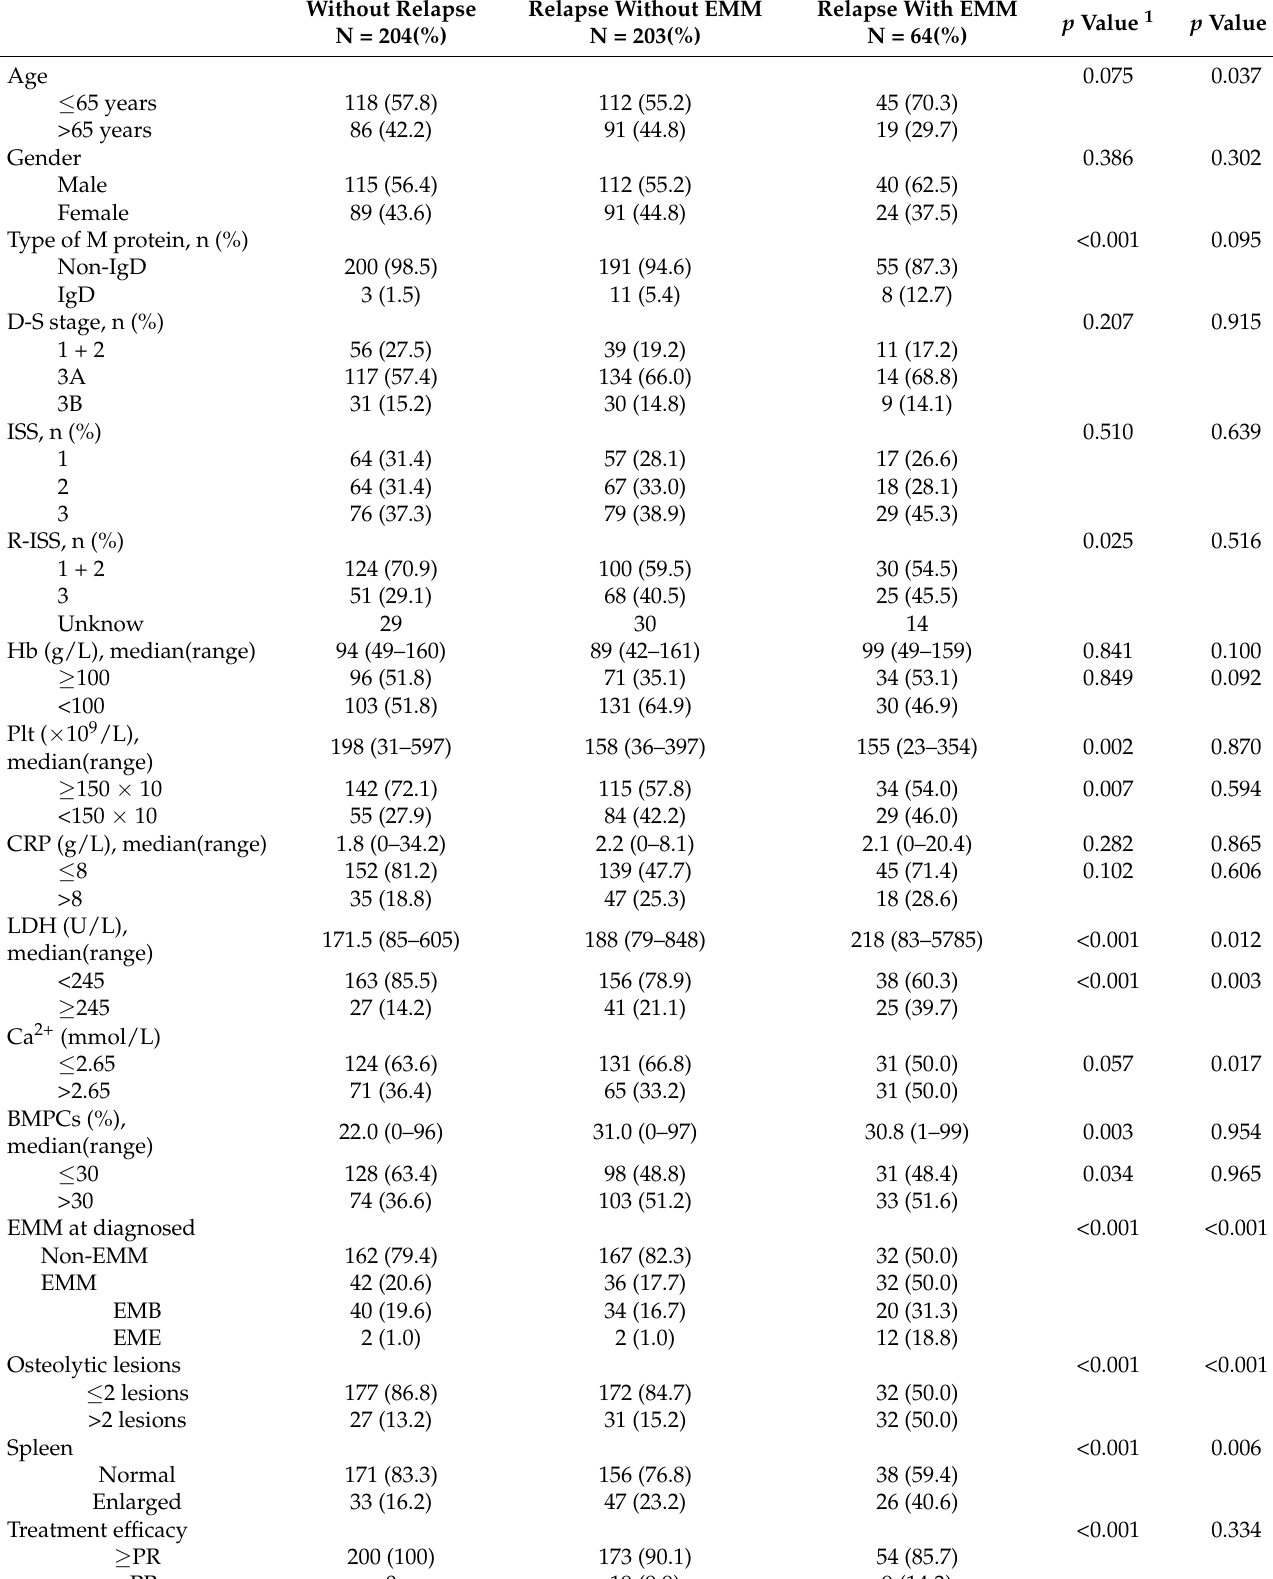
Table 1. Clinical characteristics of EMM patients (N =